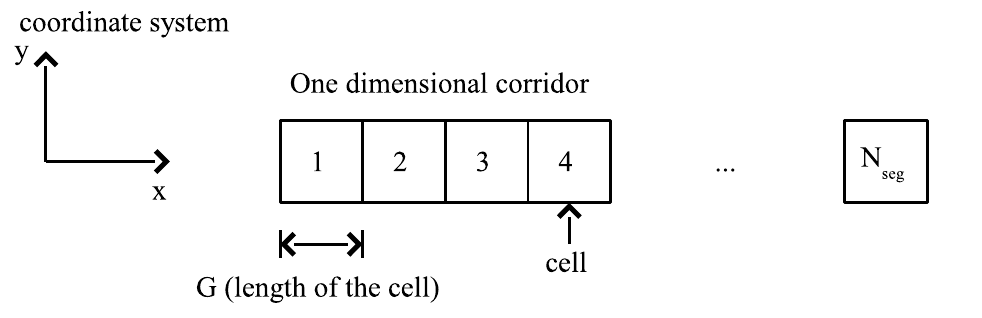
Figure 1. One-dimensional corridor is divided into cells.